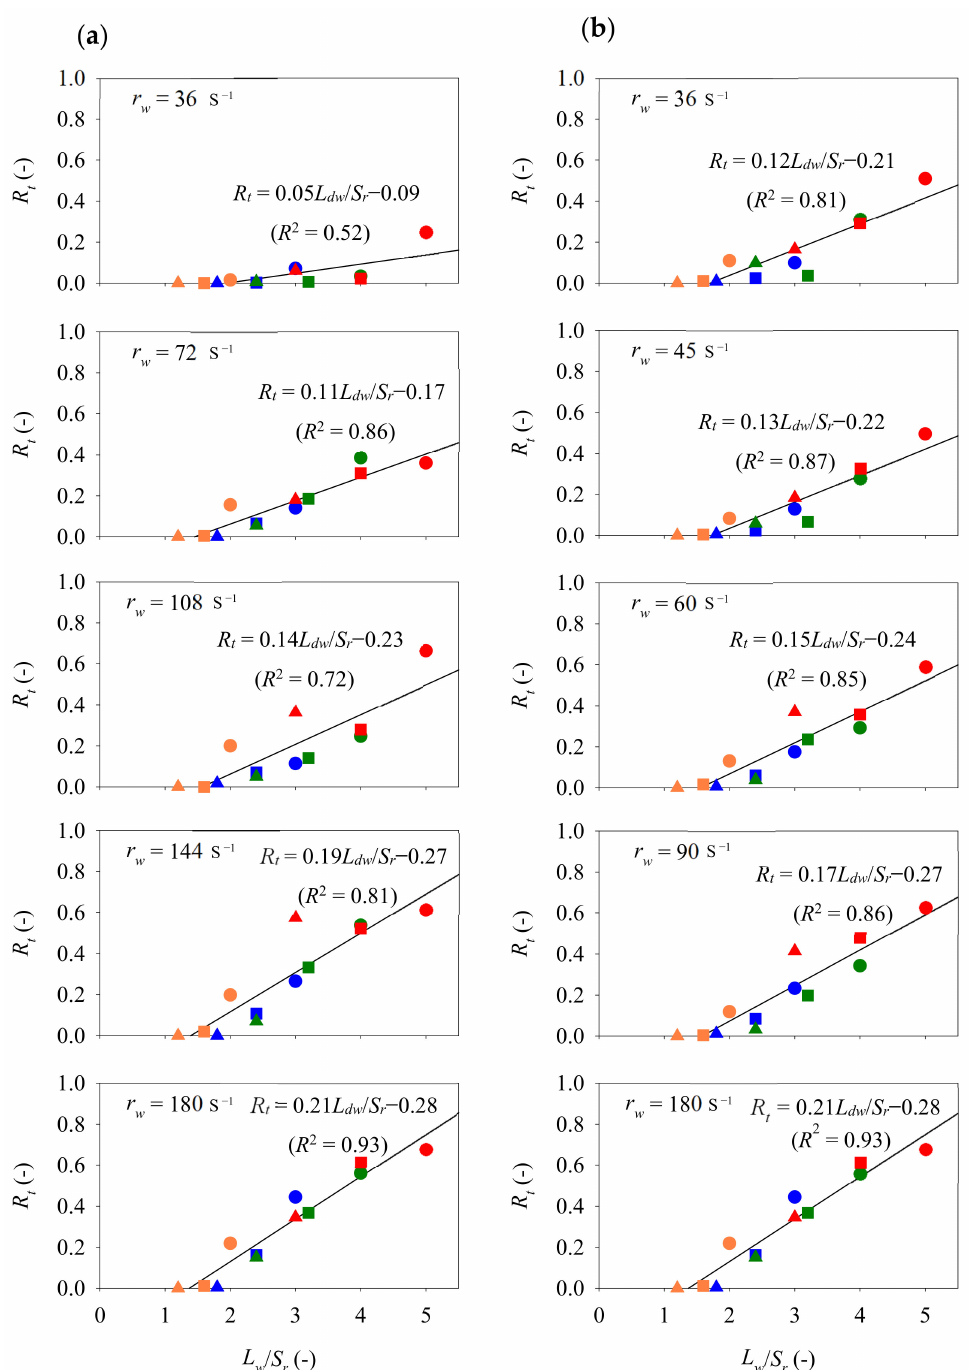
Figure 11. Experimental relationship between the relative length of LW with respect to the horizontal rod spacing ( L w / S r ) and the trapping rate ( R t ) with ( a ) the constant-spacing LW supply method, ( b ) the constant-number LW supply method (triangle: 3 rods, square: 4 rods, circle: 5 rods, orange: 4 cm, blue: 6 cm, green: 8 cm, red: 10 cm LW). The equation in each figure represents a regression line with a coefficient of determination R 2